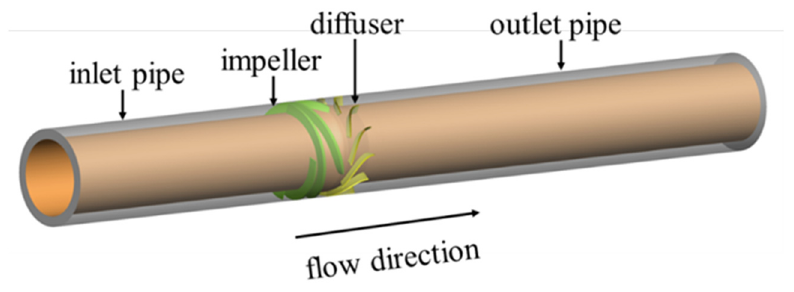
Figure 2. Computational model of an axial-flow multiphase pump. Table 1. Structural parameters.